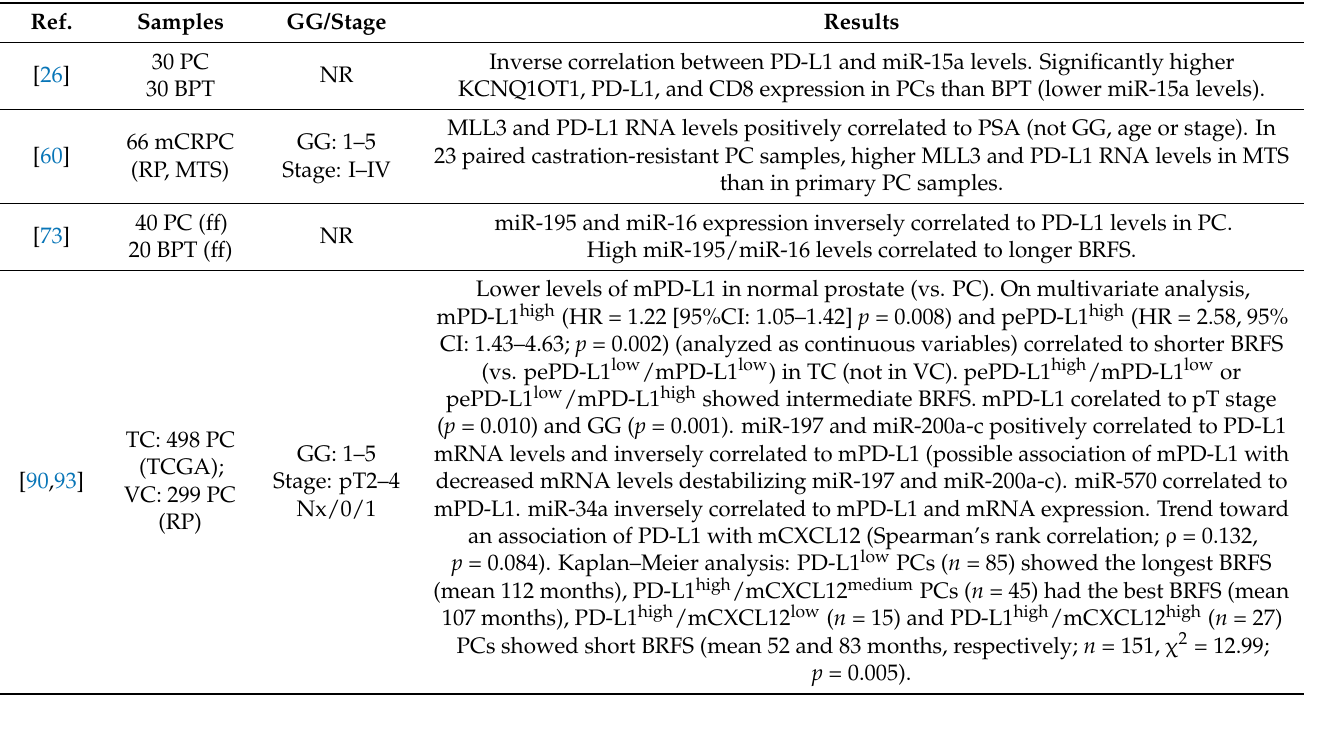
Table 3. Epigenetic regulation of PD-L1: human studies on prostatic adenocarcinoma.